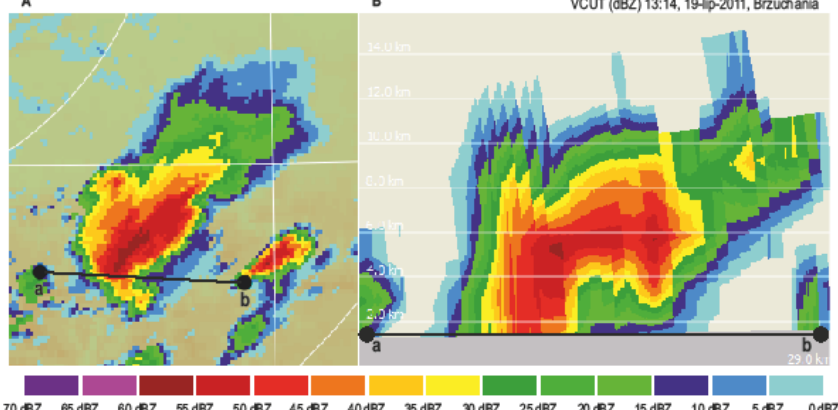
Fig. 6. Reflectivity distribution for the supercell with a hook echo near Tarnów (left picture - the PPI 0.5⁰ product, right picture - the vertical cross-section), July 19, 2011, radar Brzuchania, the black line on the PPI denotes the place of the cross-section Hail detection using the Lemon technique.